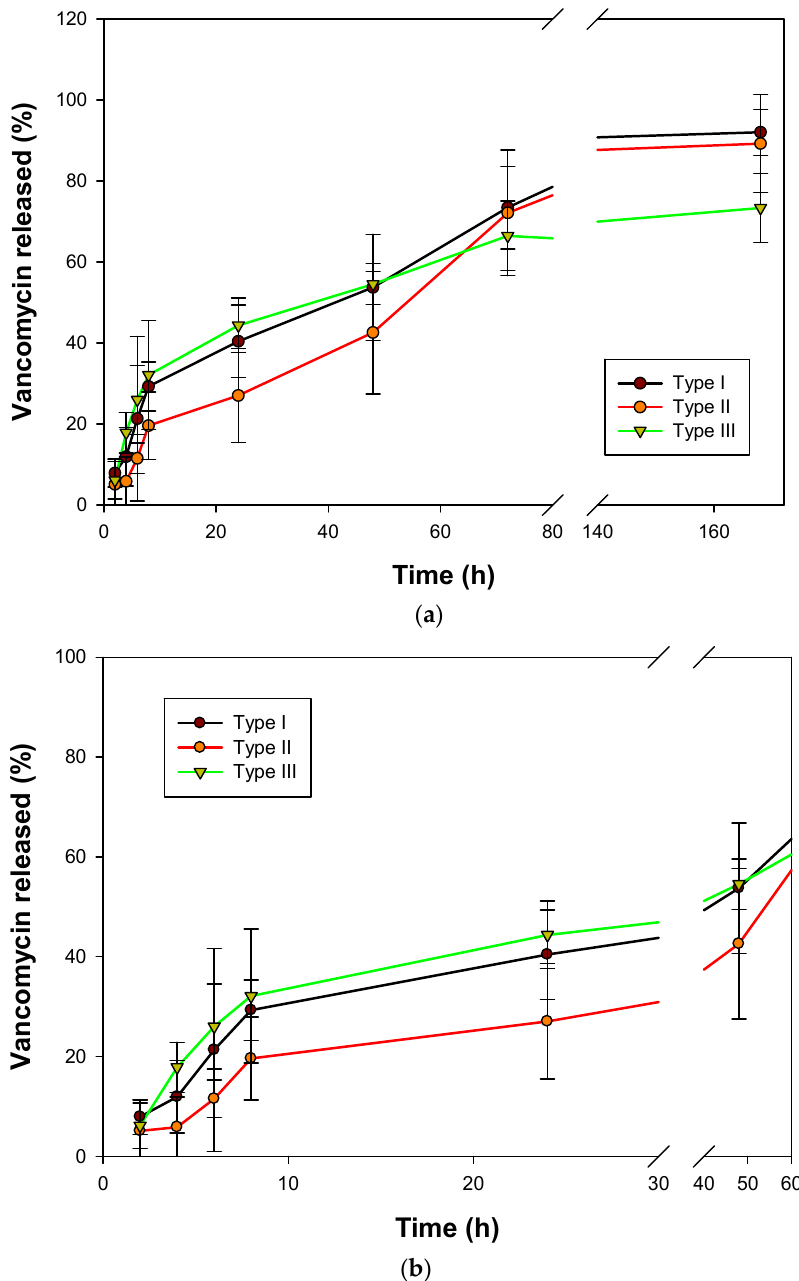
Figure 5. ( a ) Vancomycin released (%) from the 3 aerogel formulations in PBS pH 7.4 at 37 °C for 7